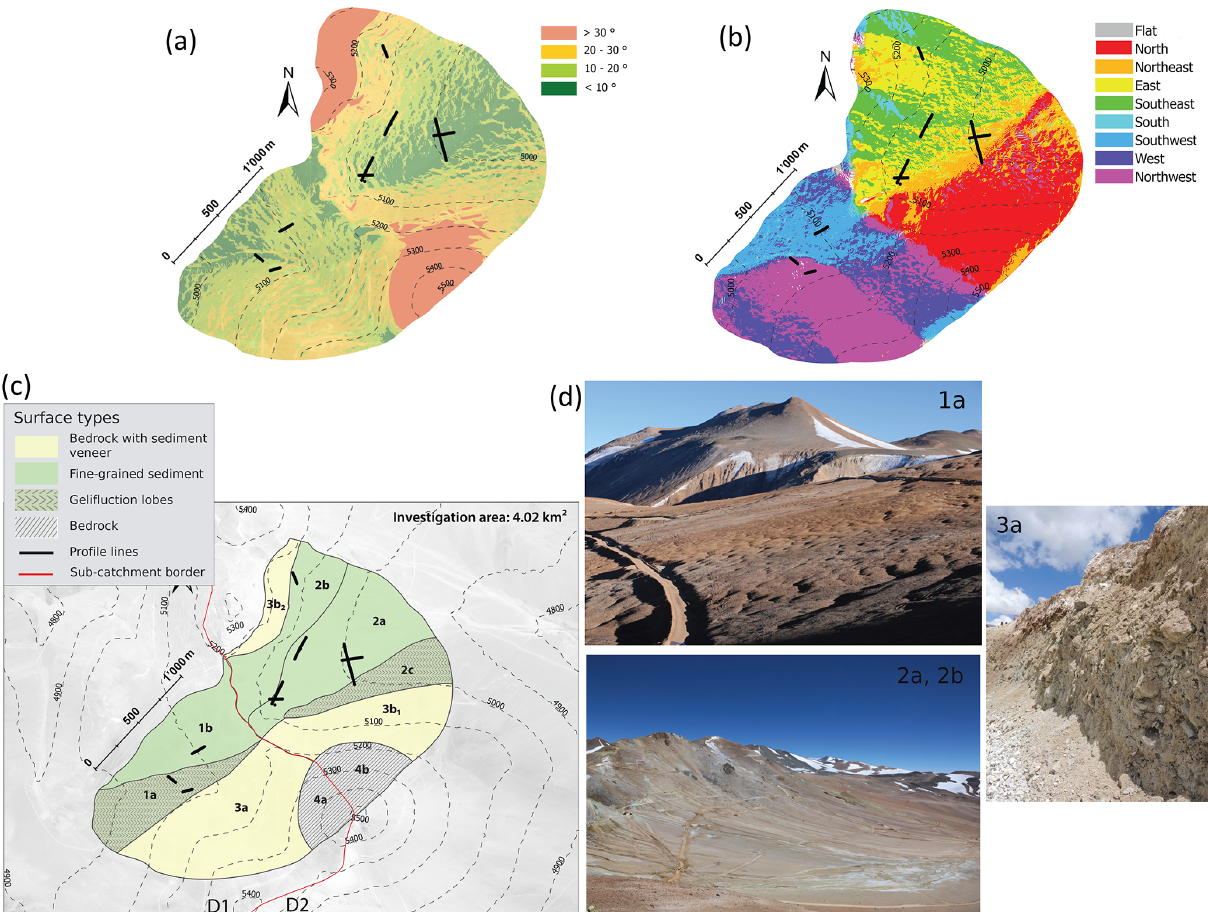
Figure 6. Map showing the different upscaling class areas for Site D (c) . The photographs (d) illustrate the general surface types for some of the most important upscaling classes (highly fractured bedrock (3a), widespread uniform fine-grained sediment (2a, 2b), and gelifluction lobes (1a)). Also shown are the slope (a) and aspect (b) maps used for the study site classification. Map data: DigitalGlobe, accessed in Global Mapper V22 (Blue Marble Geographics), date unknown.